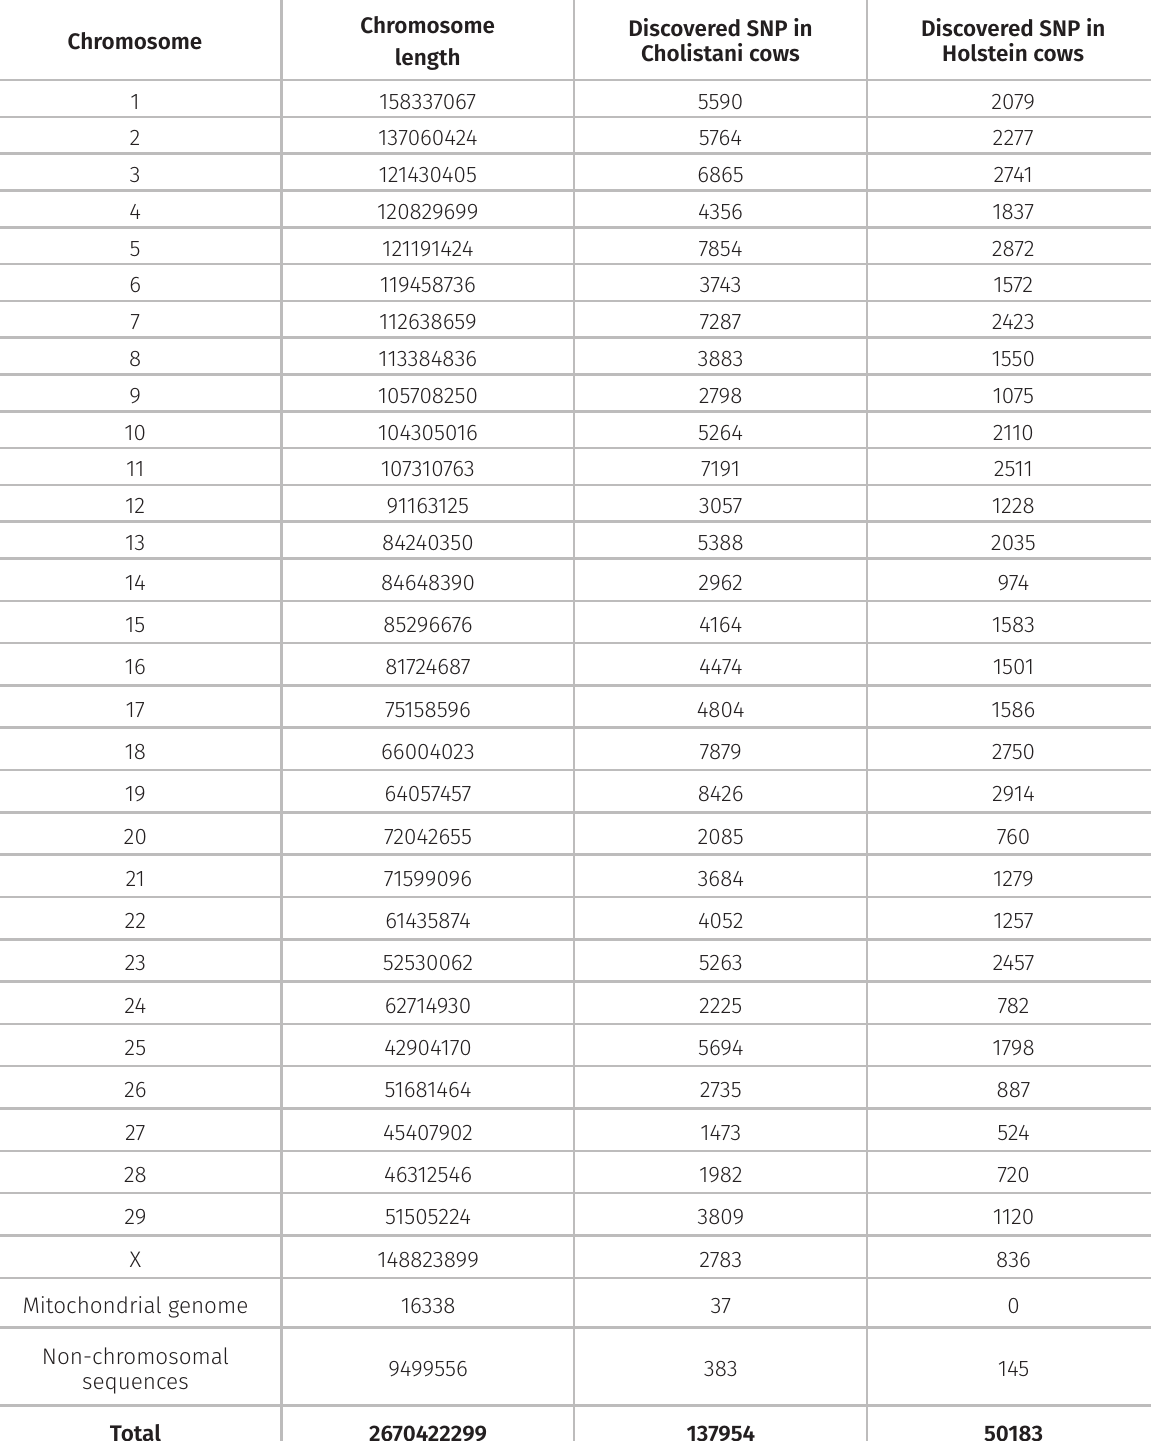
Table I. The number of discovered SNPs based on each chromosome in Holstein and Cholistani